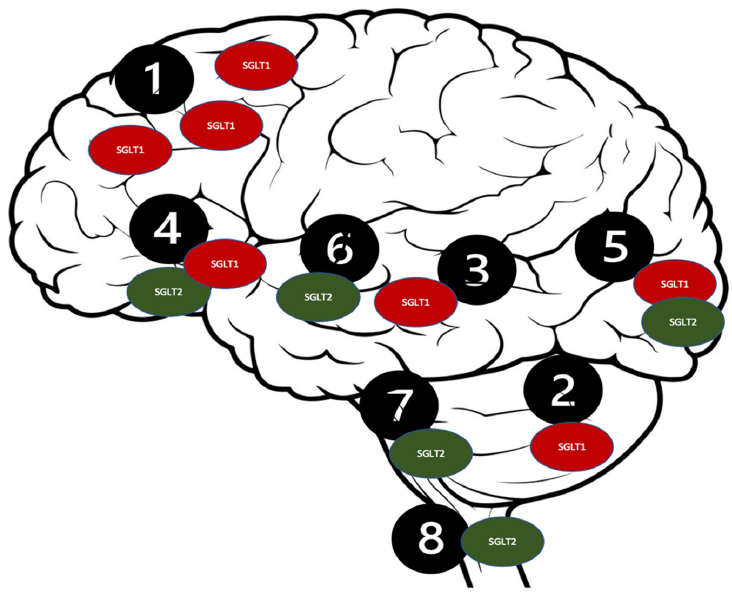
Figure 3. Distribution of the SGLT receptors in the CNS. 1. Brain cortex (pyramidal cells); 2. Purkinje neurons; 3. Hippocampus; 4. Hypothalamus; 5. Micro vessels; 6. Amygdala cells; 7. Periaqueductal gray; 8. Dorsomedial